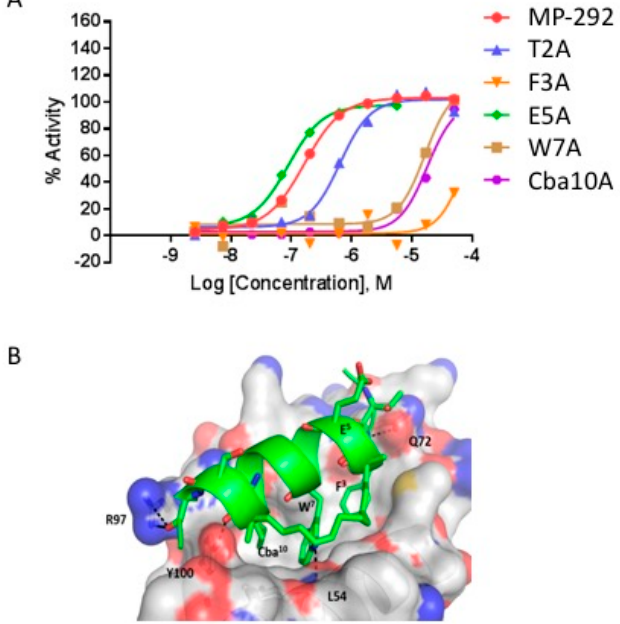
Figure 3. ( A ) Select dose response curves of MP-292 analogs containing Ala substations in the p53 reporter assay. ( B ) Model of MP-292 in complex with Mdm2. Mdm2 is shown as surface (Grey color) and the bound peptide (Green color) is shown as a cartoon. Peptide residues, staple linker, and interacting residues from Mdm2 are shown as lines, with Mdm2 / MP-292 hydrogen bond interactions shown as dashed lines (black).